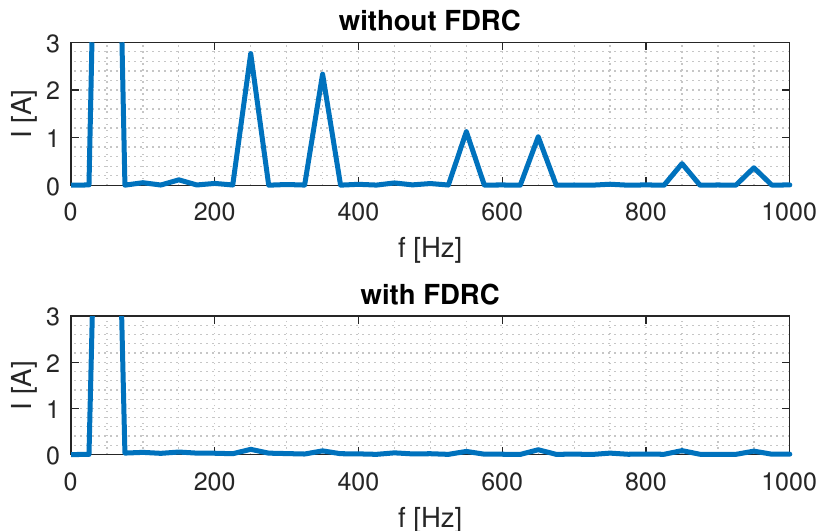
Figure 16. Spectrum of the current of one phase of the grid-tied converter without and with FDRC (experimental